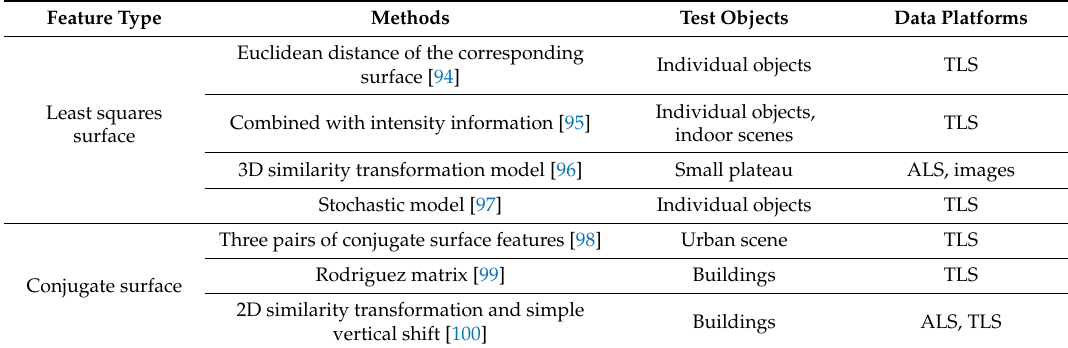
Table 4. Surface-based registration methods for point